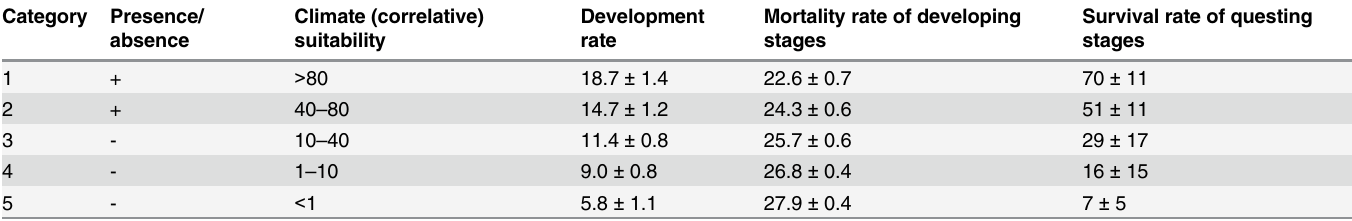
Table 1. Discrimination of five categories according to the development, mortality survival, and mortality of Hyalomma marginatum in the target territory and classified as the reported presence/absence of the tick and climate suitability. Category Presence/